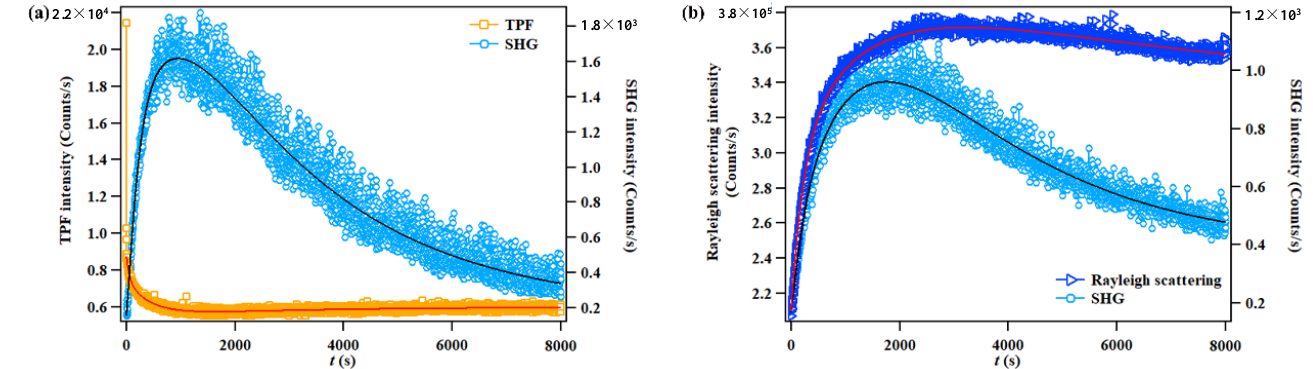
Figure 12. ( a ) Simultaneously detected TPF and SHG intensities after the mixing of DOX/AOT solutions with a final concentration ratio as 25/500 µ M. ( b ) Simultaneously detected curves of the Rayleigh scattering and the SHG intensities after the mixing of DOX and AOT solutions. For the SHG and Rayleigh curves, the points at t = 0 plotted the original signal right after the mixing of solutions. For the TPF curve, the value obtained the 25 µ M DOX solution was plotted as the initial point because the TPF emission was mostly from the DOX molecules, also because the change in the TPF signal after the mixing was so fast that large deviations were obtained for the TPF measurements at t = 0. Reproduced with permission [47]. Copyright 2022 Royal Society of Chemistry.